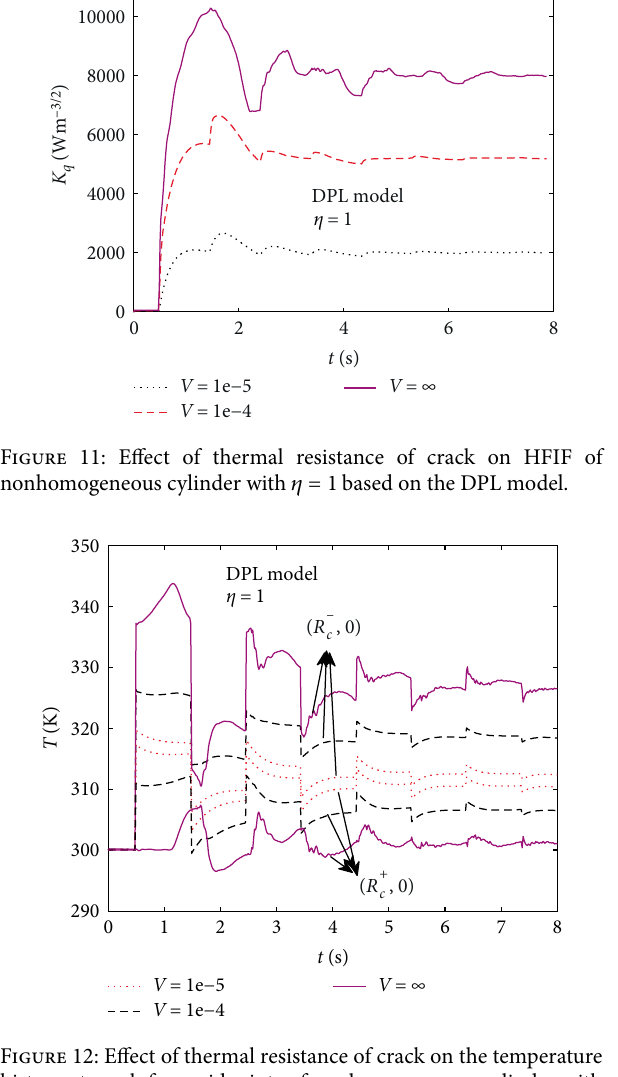
Figure 12: Effect of thermal resistance of crack on the temperature history at crack face midpoints of nonhomogeneous cylinder with based on the DPL 휂 = 1